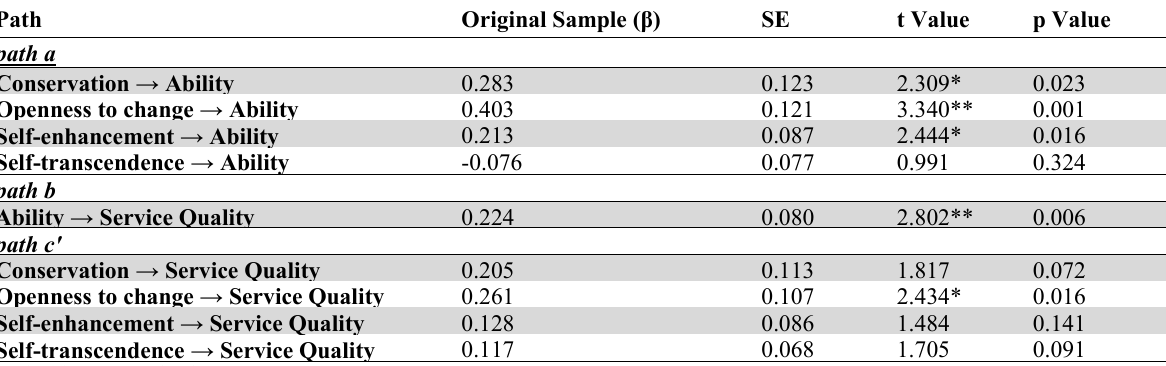
Test of the total effects using bootstrapping (ability as mediator) Path path a